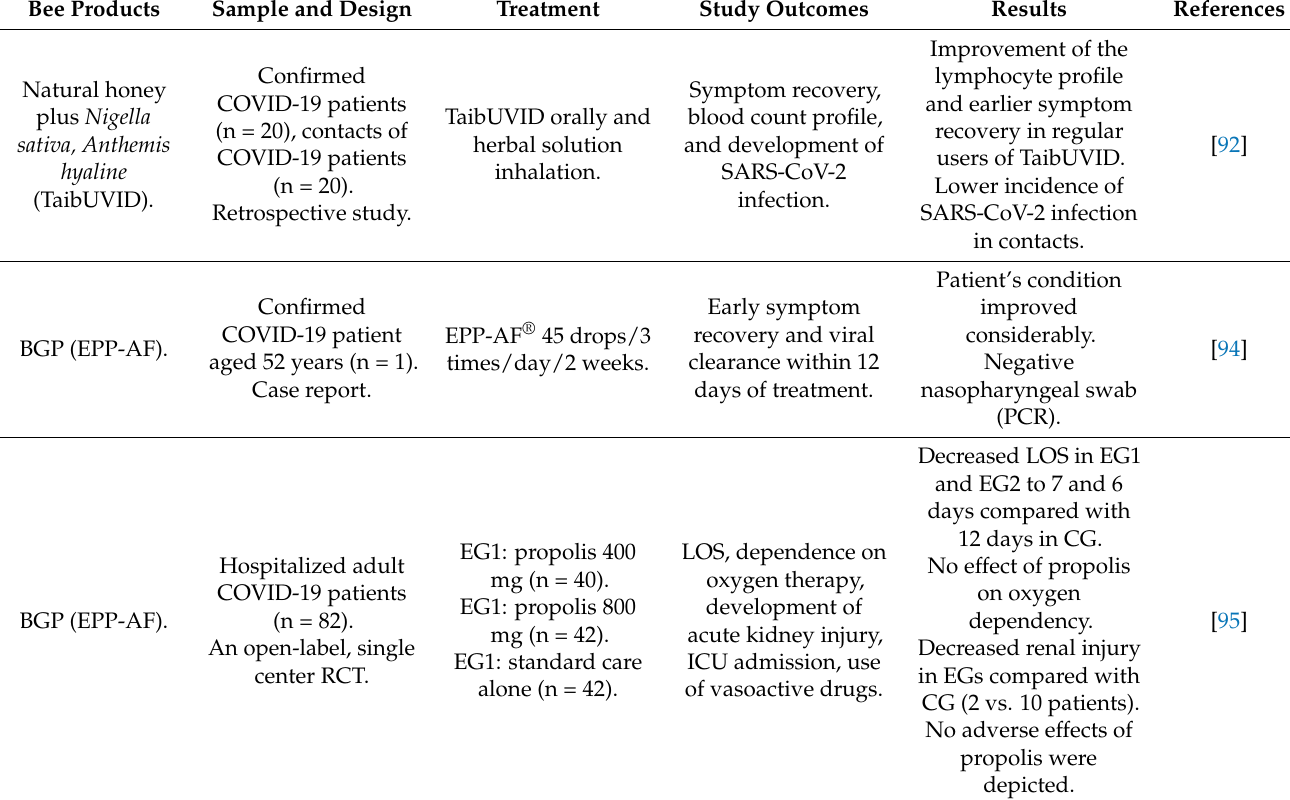
Table 2. Summary of studies treating COVID-19 patients with honey and propolis. Bee